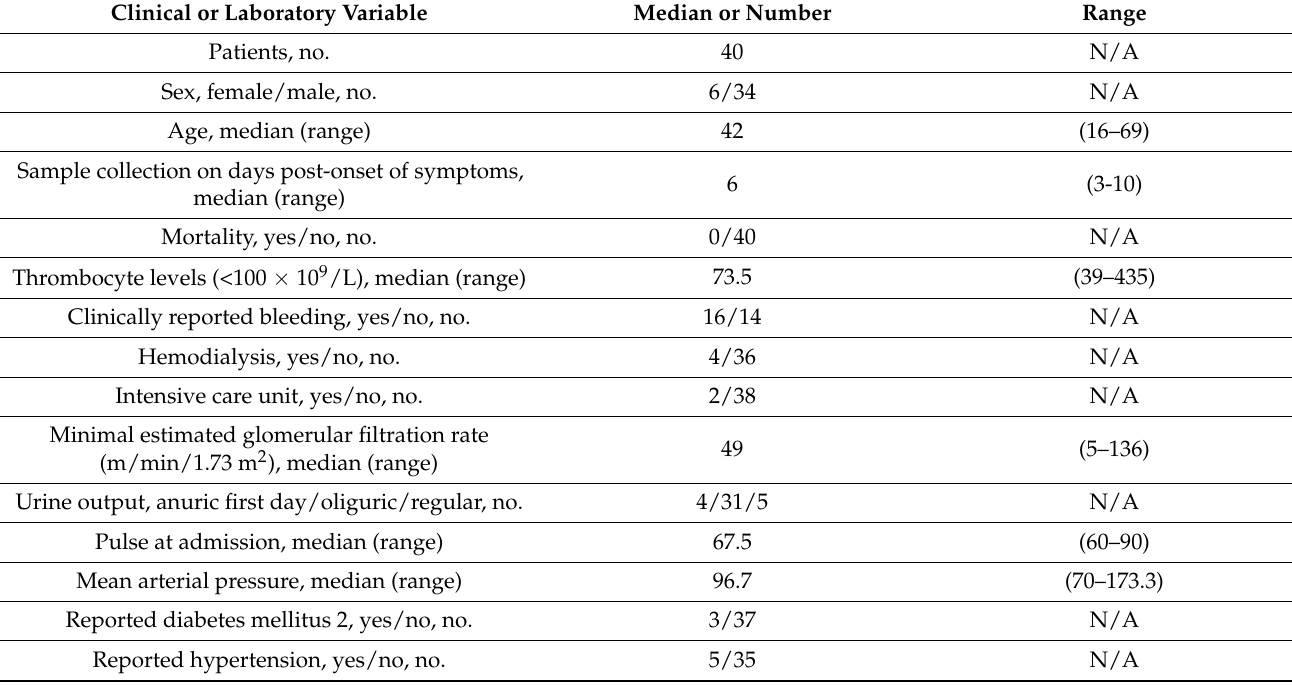
Table 1. Characteristics of forty patients included in this cohort